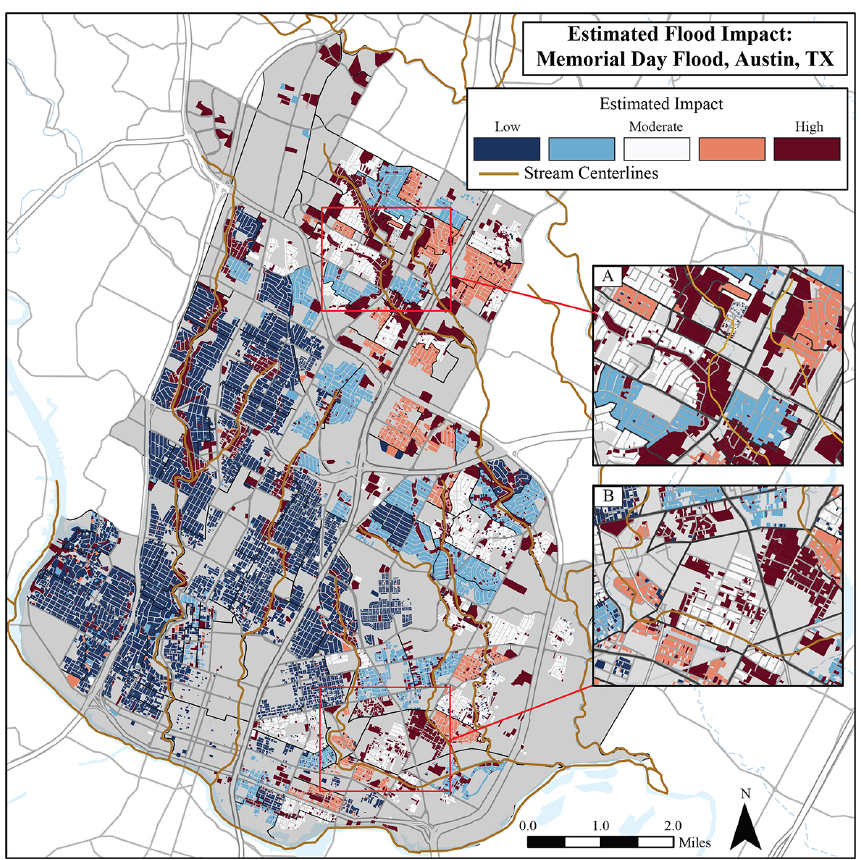
Figure 9. Residential flood impact during the 2015 Memorial Day flood in Austin, Texas. Darker reds signify a higher impact, while darker blues signify a lower